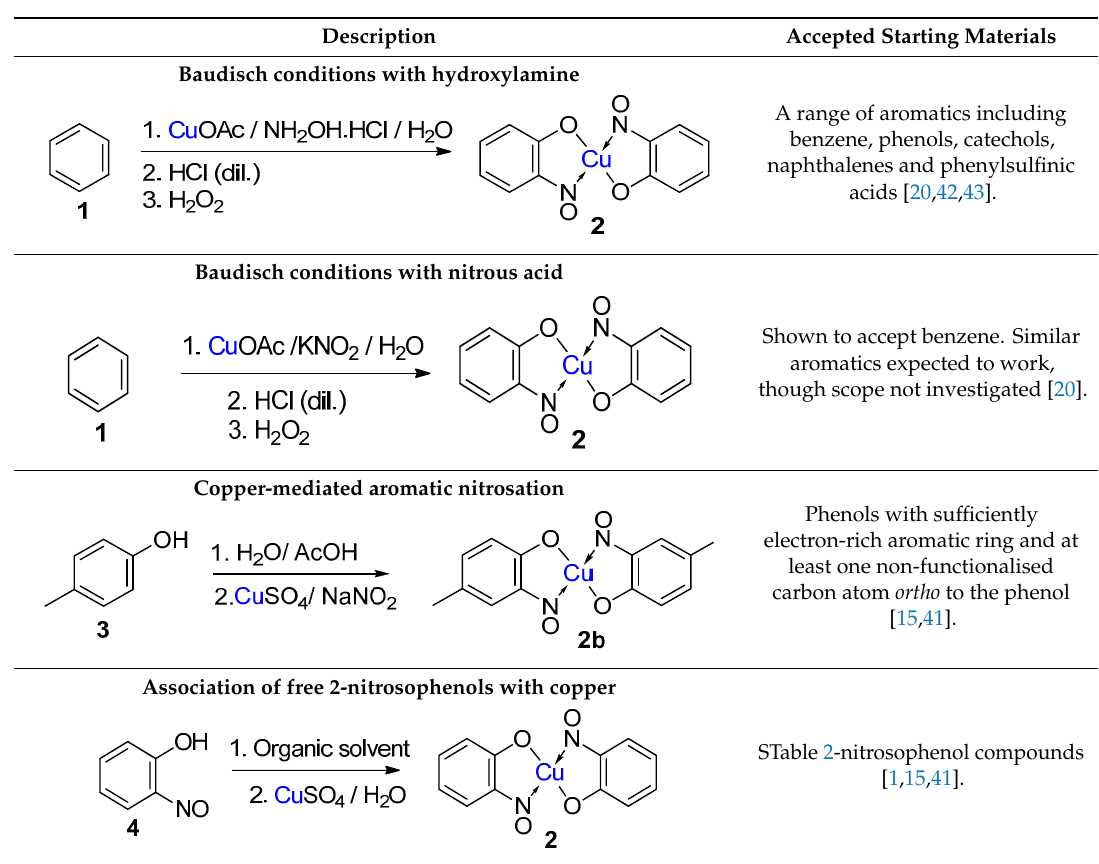
Table 1. General conditions reported to produce metal-nitrosophenolato complexes, highlighting a representative copper example for each case.